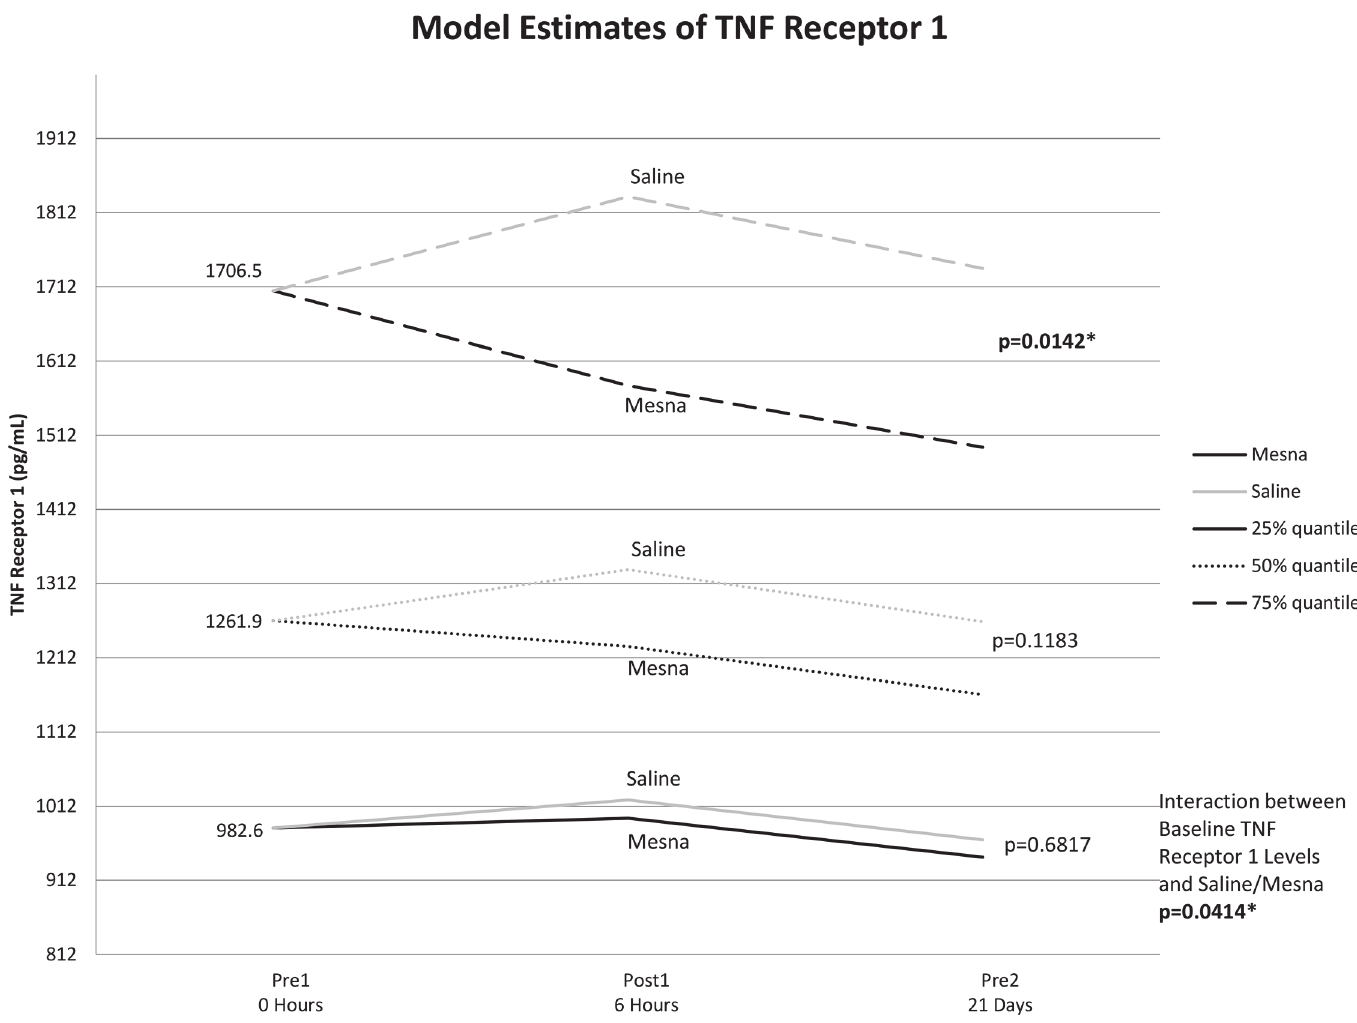
Fig 4. Mean estimates of TNF receptor 1 levels for each time point by mesna and saline groups calculated from linear mixed model adjusting for baseline level, time, group (mesna vs saline), chemotherapy regimen and baseline by group interaction.